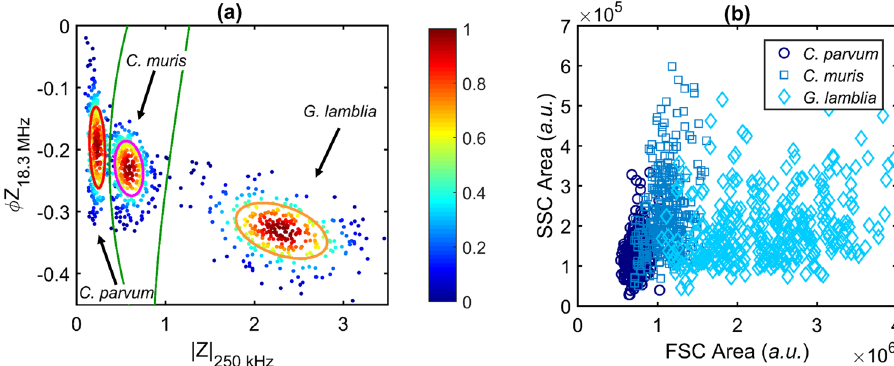
Figure 8. Impedance vs optical detection of parasites. ( a ) Scatter plot of phase at 18.3 MHz vs impedance magnitude at 250 kHz for all parasite species measured together in a mixed sample. Annotated confidence ellipses contain ~50% of each population. Green lines indicate boundaries defining equal probability deviation between adjacent populations. The colour of each data point represents the normalized proximity of the event to the respective population mean. ( b ) Conventional flow cytometry data (SSC vs FSC) for all parasite species in PBS. Individual optical scatter data for each population plotted together. A total of 1,000 events are plotted in both ( a ) and ( b